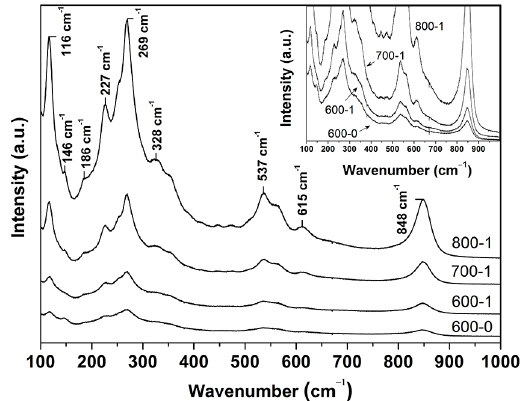
Table 3. Raman phonon modes and their respective structural assignments.